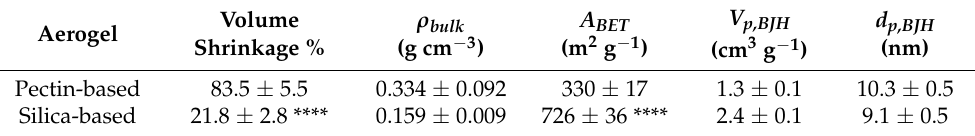
Table 1. Physicochemical properties of the aerogels prepared.